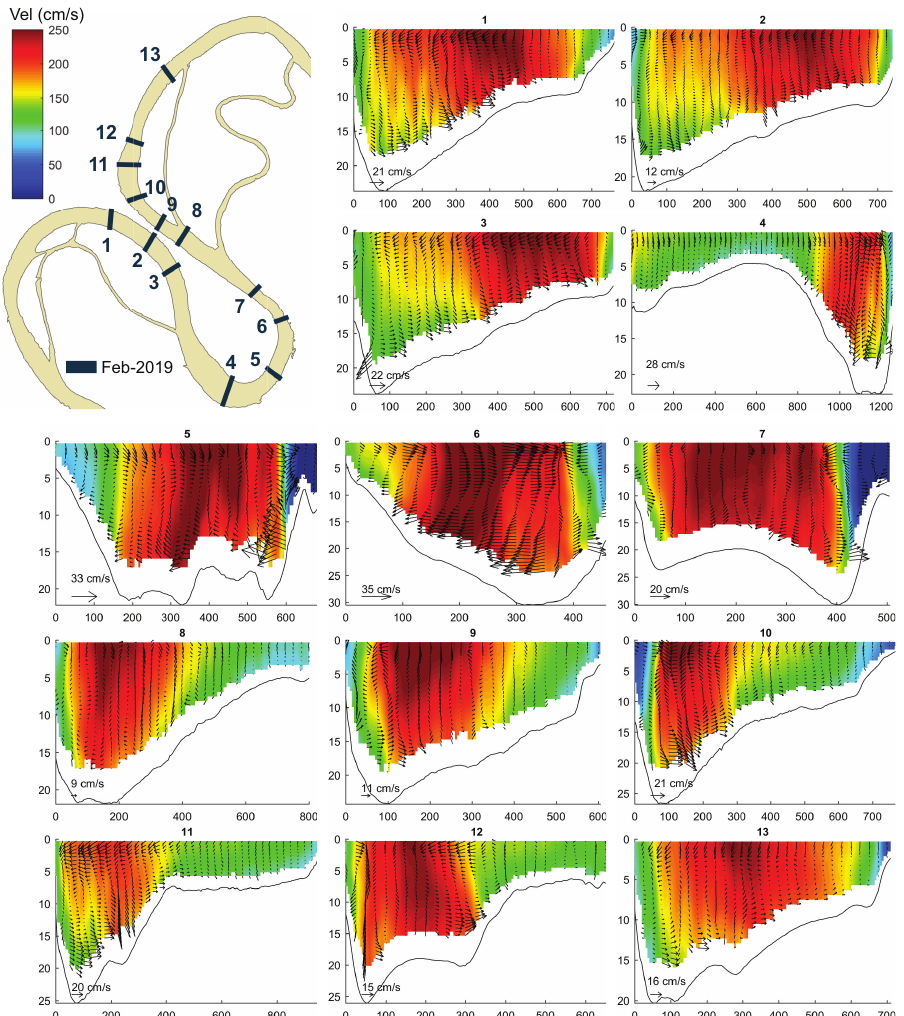
Figure 8. February 2019’s velocity measurements along the JH bend. The vectors represent the secondary flow using the Rozovskii decomposition, while the contours represent the velocity magni- tude. February ´ s water discharges (Q (m 3 /s)) are 18,825.8 (1), 18,900.3 (2), 18,682.5 (3), 19,541.6 (4), 19,256.8 (5), 19,331.3 (6), 19,471.3 (7), 17,521.5 (8), 16,642.3 (9), 16,392.4 (10), 16,257.8 (11), 16,148.3 (12), and 16,138.9